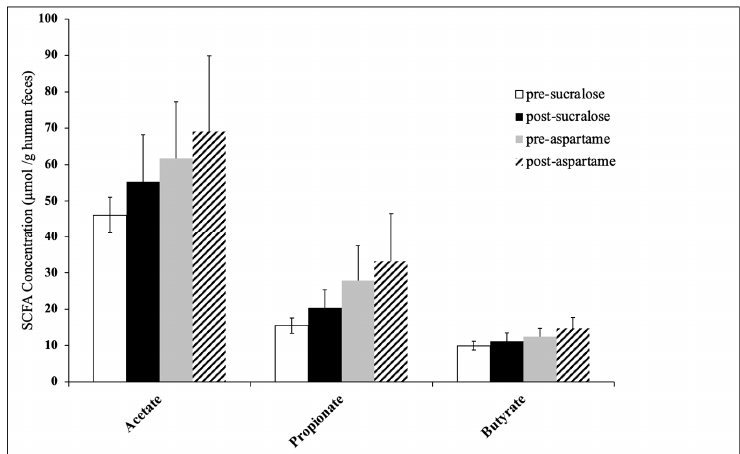
Figure 5. Short-chain fatty acid concentration from the human faeces metabolomics analysis before and after sucralose or aspartame treatments. Data are presented as the means ± standard error (SE), n = 14 – 16.